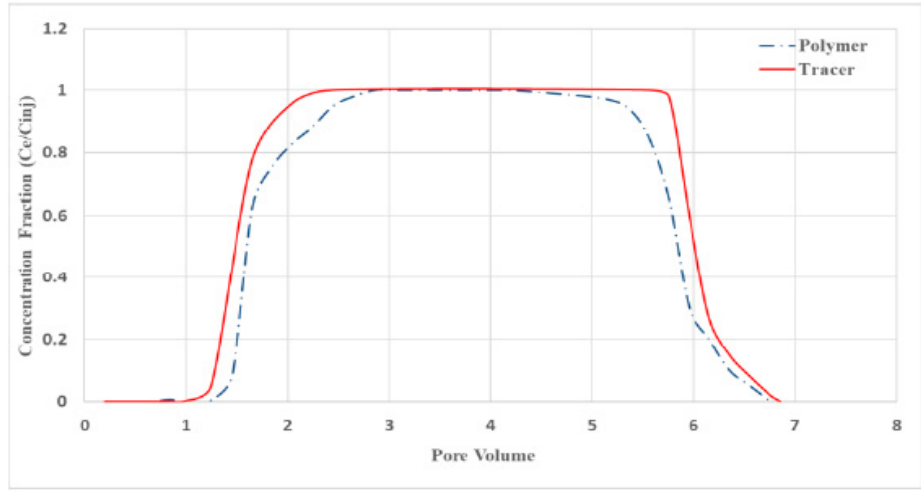
Figure 3. Single front method. Polymer and tracer are injected together and then flushed with water. The concentrations are analyzed during the process to determine the delay between tracer and polymer.